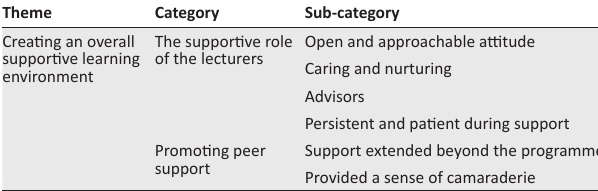
TABLE 1: Theme and